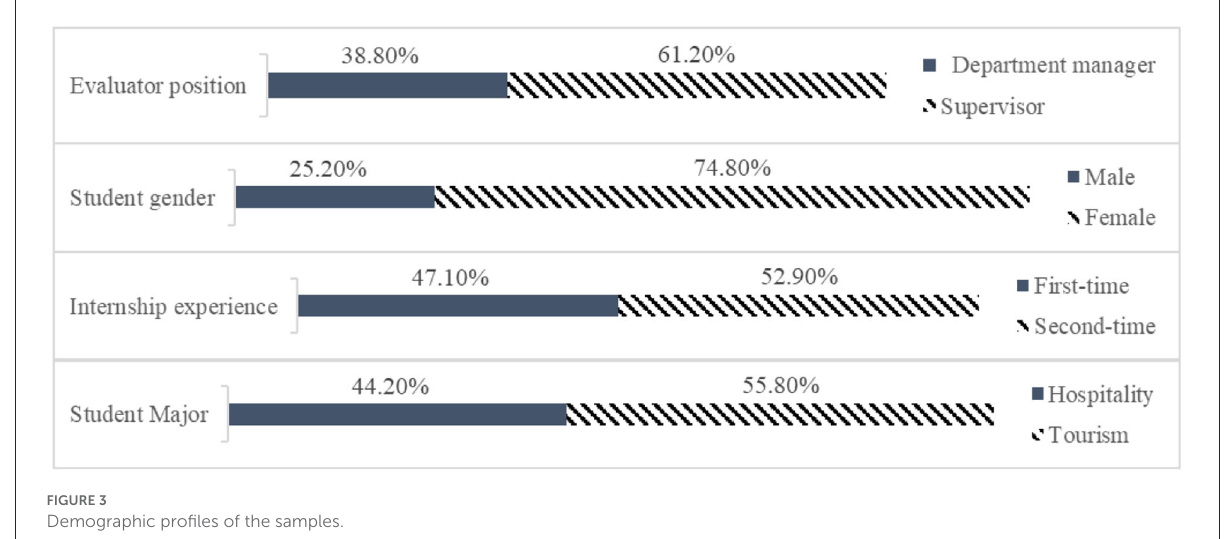
FIGURE3 Demographic profiles of the samples.